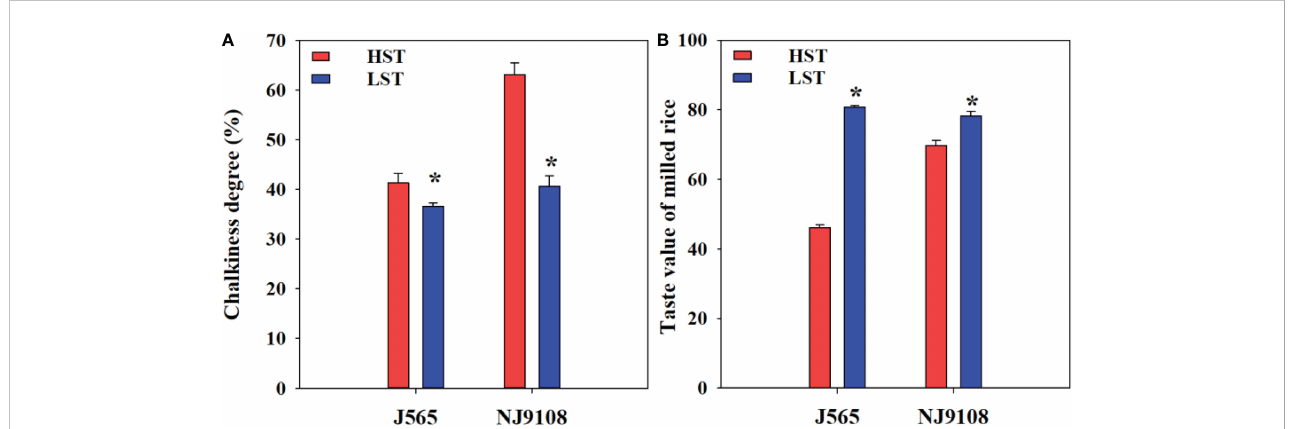
FIGURE 2 Chalkiness (A) and taste value of milled rice (B) in the two growth seasons. HST and LST represent high seasonal temperature and low seasonal temperature, during the reproductive stage in 2017 and 2018. J565 and NJ9108 represent cultivars Jing-565 and Nanjing-9108. * represents signi fi cant difference between HST and LST at the level of P <